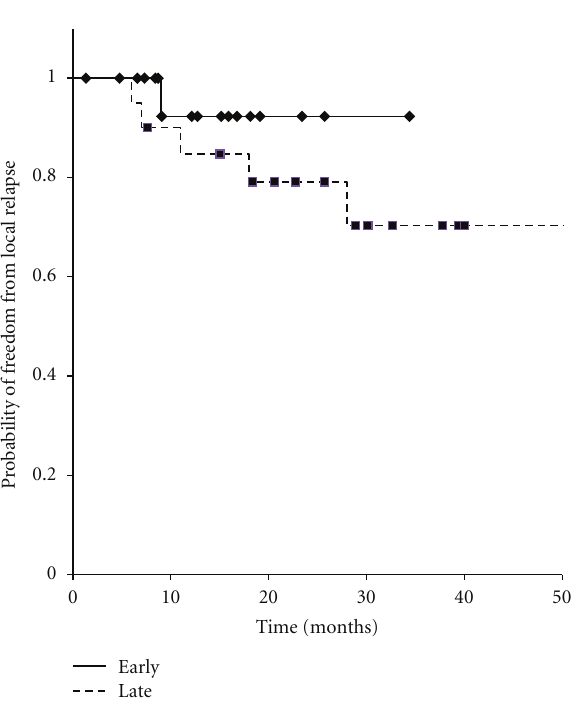
Figure 4: Kaplan-Meier curves for local control in 42 patients with oligo-recurrence cancer in the lung, early recurrence group versus late recurrence